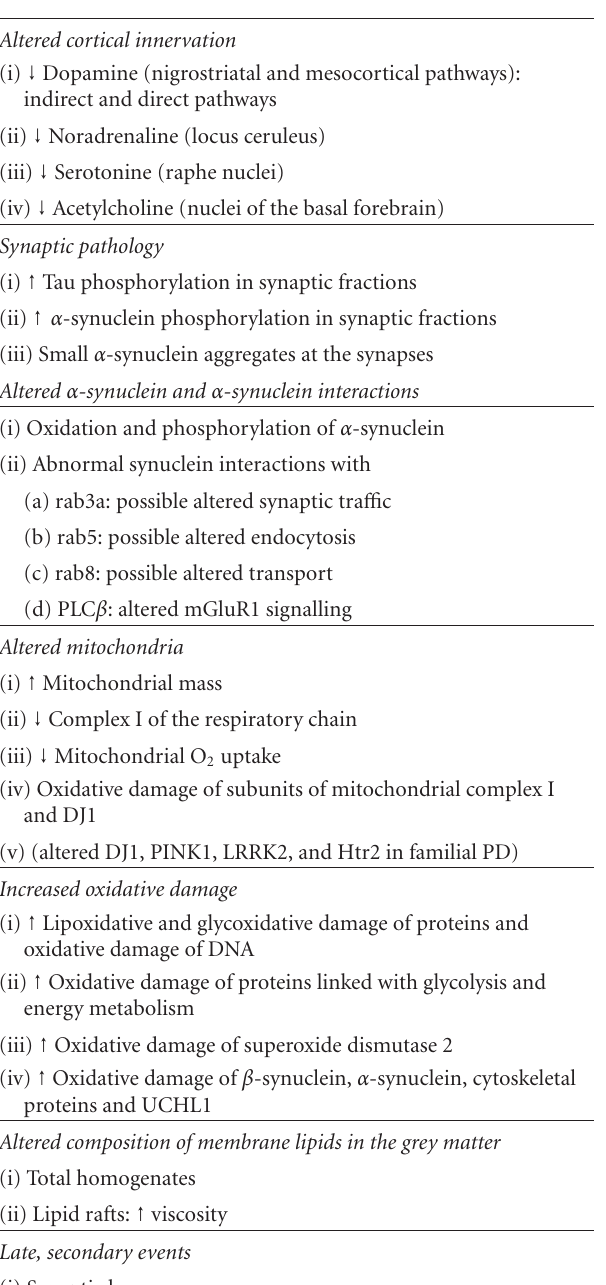
Table 1: Convergence of altered metabolic events in the cerebral cortex in Parkinson